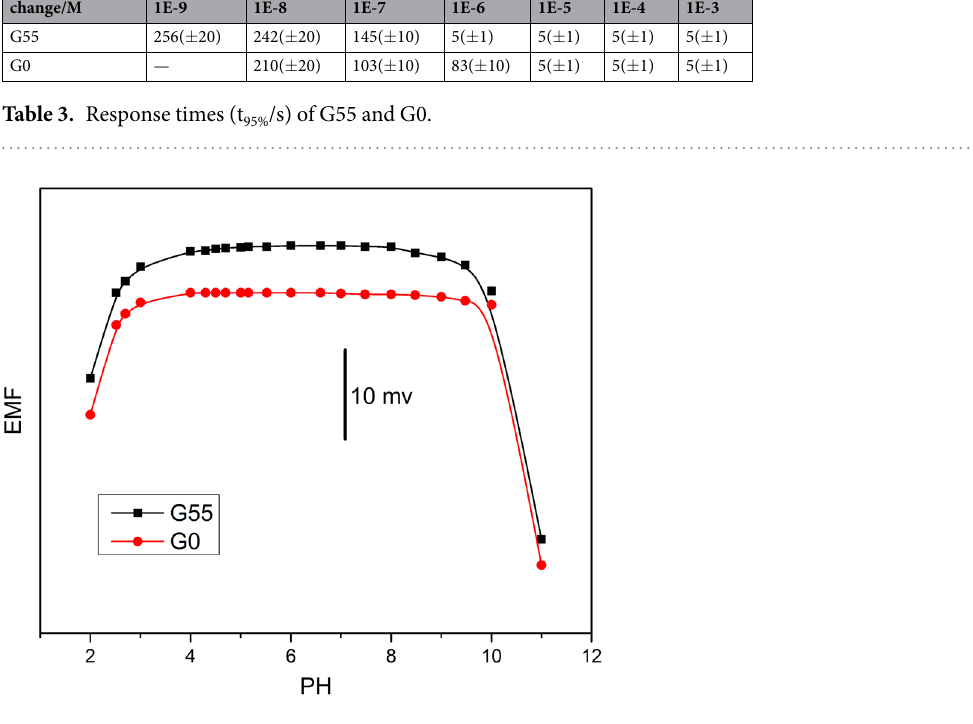
Figure 6. Influence of pH value on the potential of G55 and G0. Concentration of AgNO 3 : 1